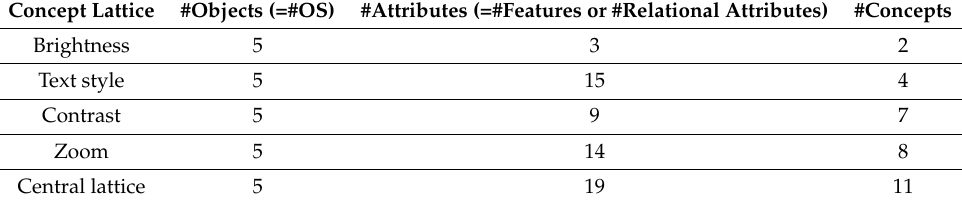
Table 7. Metrics on the objects, attributes and concepts for the fictitious